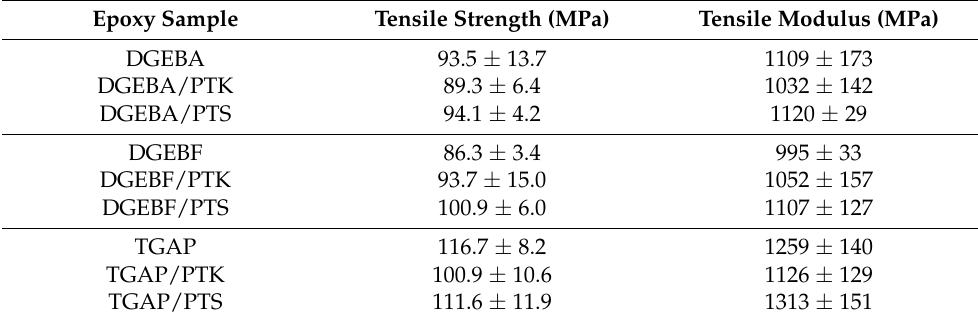
Figure 7. Fracture toughness of the prepared samples. Table 1. Tensile properties of the prepared